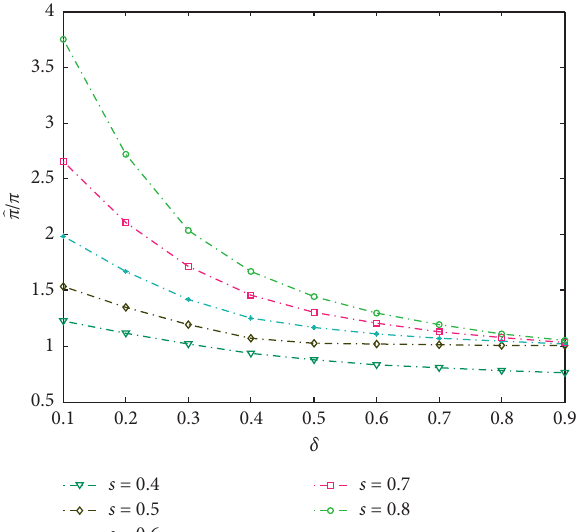
Figure 6: The effect of s and δ on the profit ratio 􏽢 π / π .